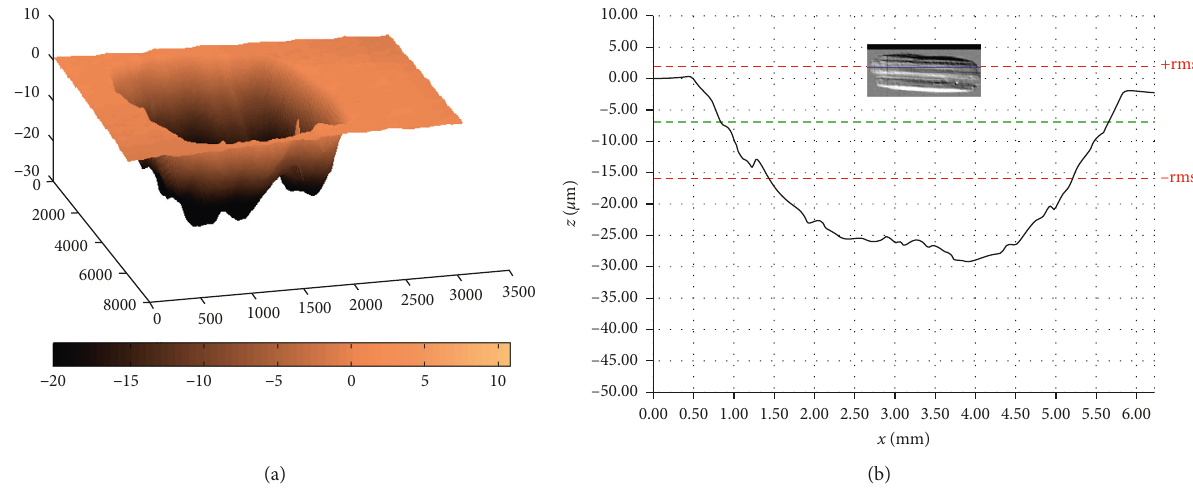
Figure 18: Three-dimensional image of the disk track of steel 2 tested at 200 ° C (a). The maximum profile depth (29 µ m)